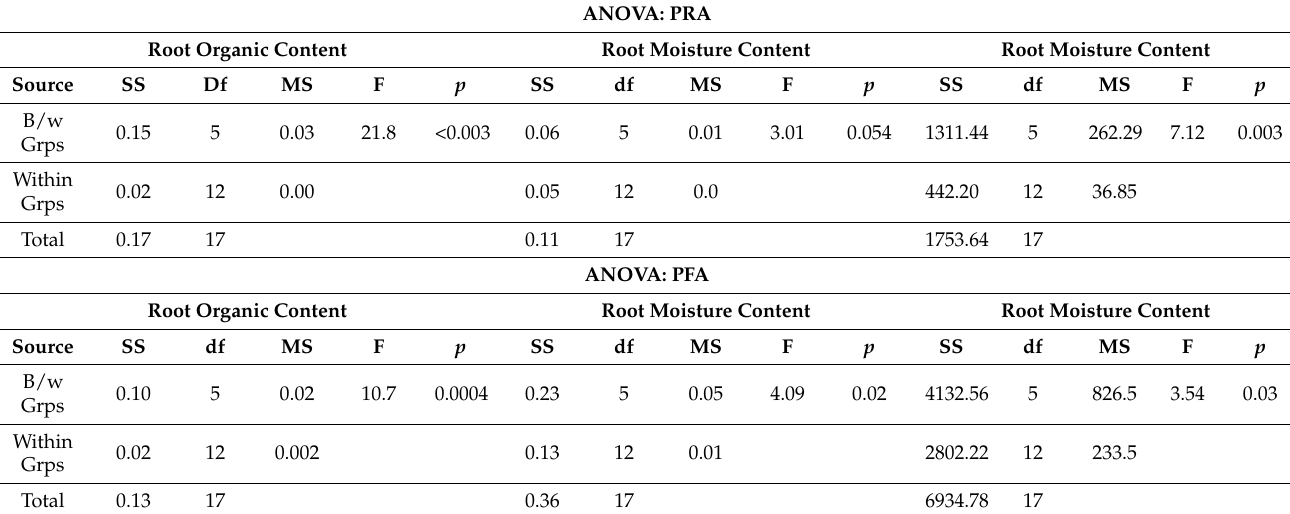
Table 7. ANOVA showing the efficacy of ANE via PFA and PRA experiments on biomass accumulation in roots. ANOVA: PRA Root Organic